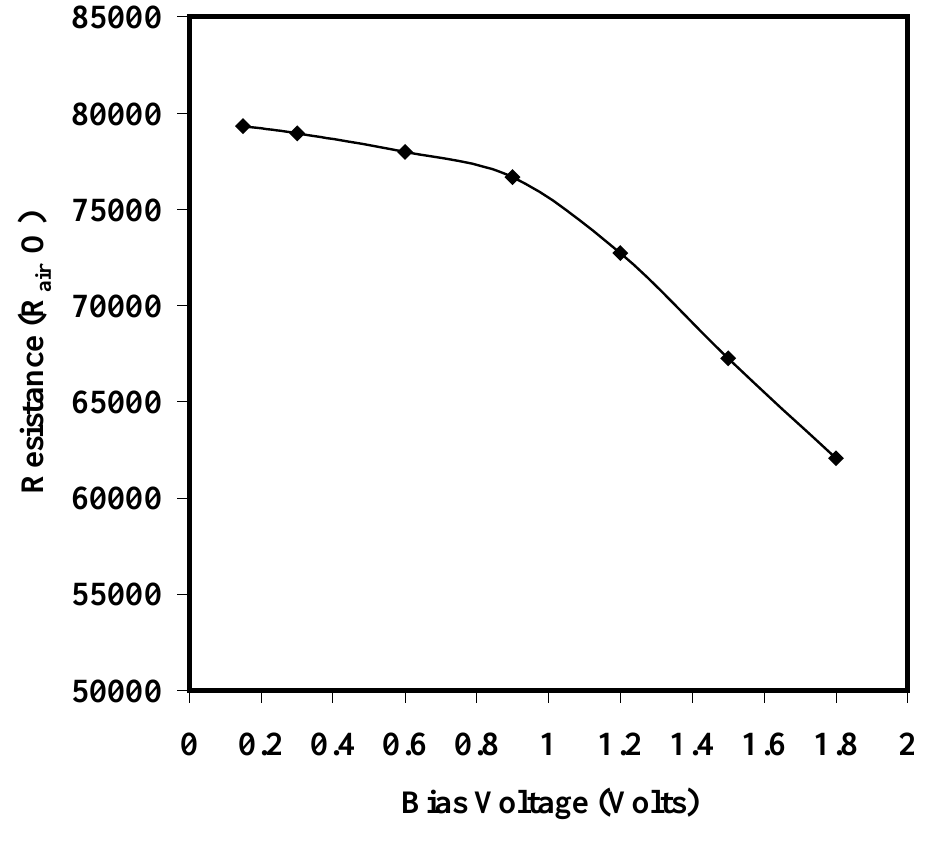
Figure 4. Variation of SnO sensor resistance in air with bias voltages at 350 o C 2 for film thickness of 200